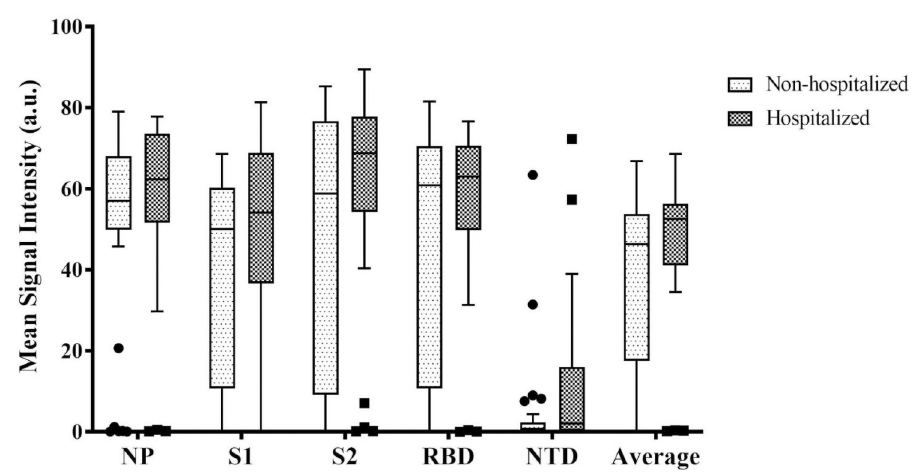
Fig 3. IgG profile depending on disease severity outcome. Distribution of the different IgG responses based on the MSI in arbitrary units (a.u.), considered individually, or altogether (average) for hospitalized (n = 25) and non- hospitalized patients (n = 34) just after infection.